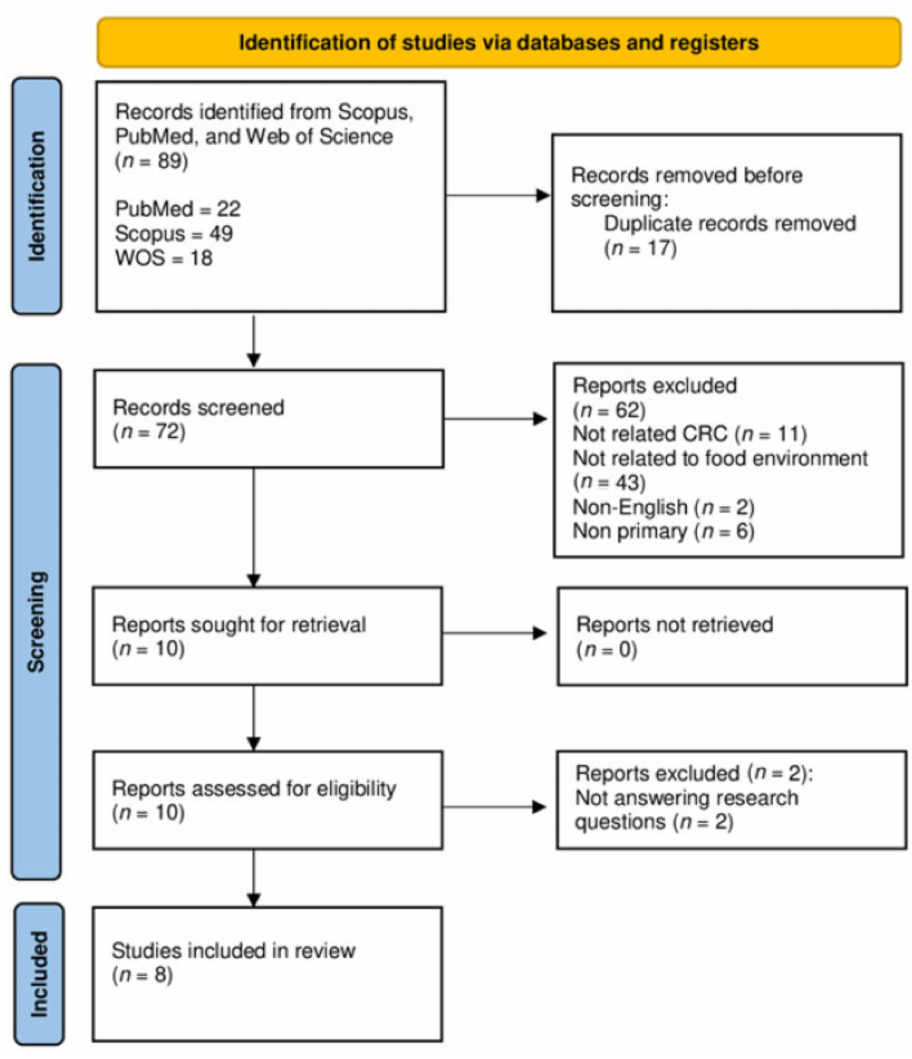
Figure 1. A PRISMA flow chart. WOS, Web of Science; CRC, colorectal